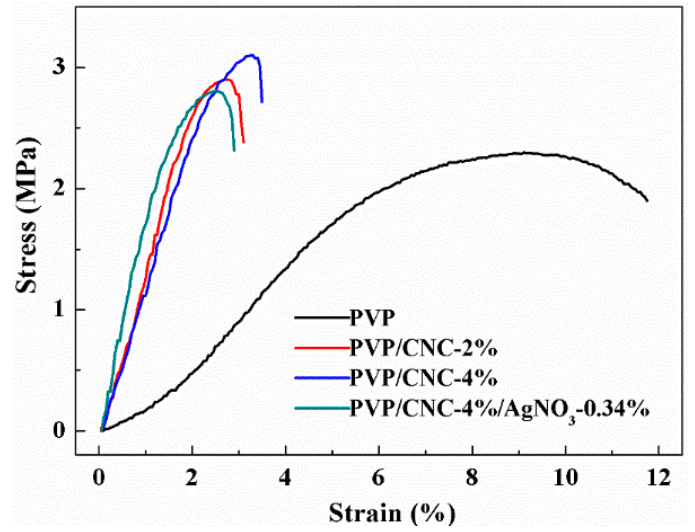
Figure 6. Typical stress-strain curves of electrospun pure PVP, PVP/CNC-2%, PVP/CNC-4%, and PVP/CNC-4%/AgNO 3 -0.34% composite fiber mats. Table 4. Tensile properties of electrospun pure PVP, PVP/CNC-2%, PVP/CNC-4%, and PVP/CNC-4%/AgNO 3 -0.34% composite fiber mats. Sample Elongation at Break